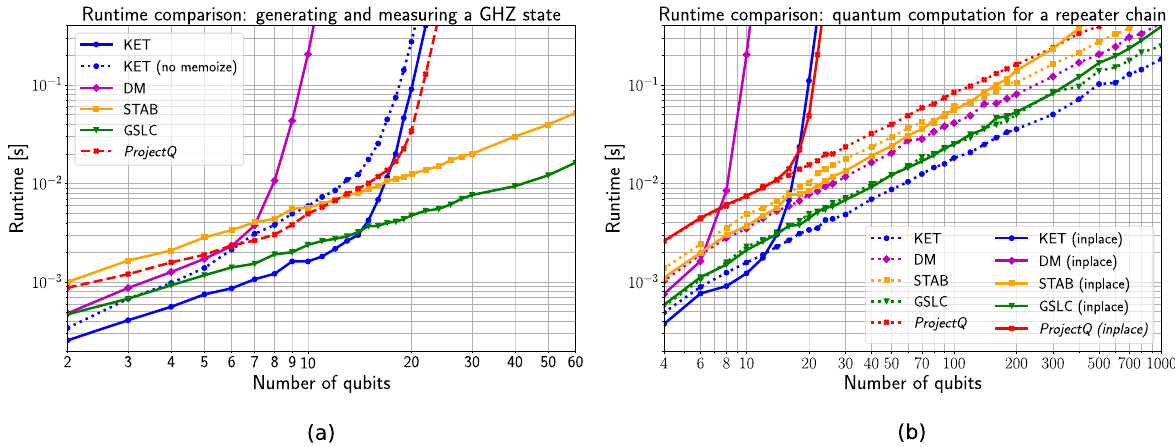
Fig. 8 Runtime comparison of NetSquid ’ s quantum state formalisms. Runtime comparisons of the available quantum state formalisms in NetSquid as well as ProjectQ ket vector for two benchmark use cases. The KET, DM, STAB and GSLC formalisms refer to the use of ket vectors, density matrices, stabiliser tableaus and graph states with local Cliffords, respectively. a Generating a Greenberger-Horne-Zeilinger (GHZ) state. Qubits are split off from the shared quantum state after a measurement. For the KET formalism the effect of turning off memoization (dotted line) is also shown. b Quantum computation involved in a repeater chain. Each formalism is shown with qubits split (dotted lines) versus being kept in-place (solid lines) after